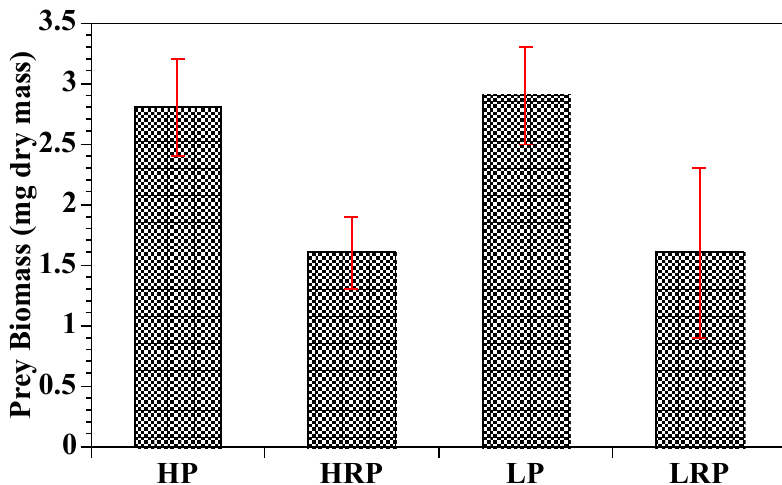
Figure 5. Estimated mass of individual yellow perch stomach contents collected at the conclusion of the ruffe and fish density experiment 1 (24 October 1996). Treatment means are shown plus or minus one standard error. There are four replicates of each treatment except LRP ( n = 3). HP = 28 perch, HRP = 14 perch + 14 ruffe, LP = 14 perch, and LRP = 7 perch + 7 ruffe. Analysis of the gradient experiment diet data was hindered by low fish recovery from the second trial at the end of the experiment that was due in part to predation by an otter that was first observed in Perch Lake during the final week of the experiment. Therefore, we restricted diet analysis to the first two replicates. There was a significant negative effect of ruffe on the total mass of prey in perch stomachs ( t test, p = 0.014), but no significant effect of ruffe on ruffe stomach content mass (Figure 6). Perch density did not affect the stomach content mass of either species. As in the first experiment, there was no significant effect of ruffe on the proportion of zooplankton in perch diet. Cladocera and Copepoda composed about 12% of perch diet and <1% of ruffe diet.